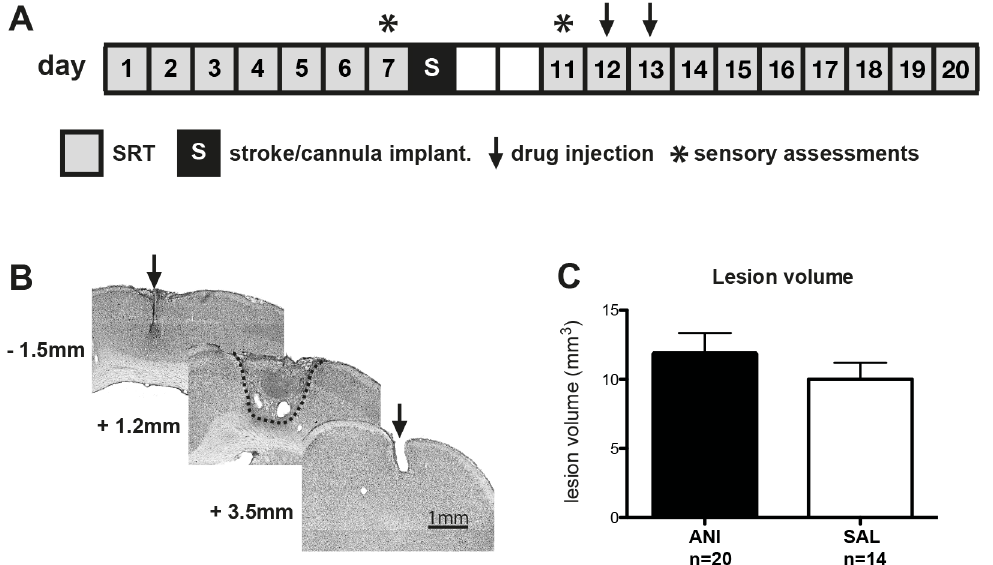
Fig 1. A Experimental design indicating the timing of behavioral training and interventions. 20 rats were injected with anisomycin (ANI), 14 rats were injected with saline (SAL). B Coronal sections stained with cresyl violet from a representative animal. The arrowheads indicate the placement of injection cannulas and the dashed line indicates the photothrombotic lesion. Longitudinal coordinates refer to bregma. C Volumes of photothrombotic strokes are not different between groups. Values represent mean ±